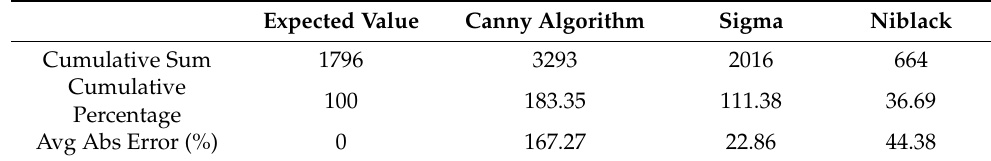
Table 4. Area in pixels of blob defects.